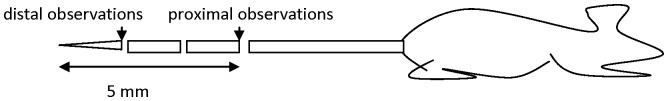
Locations of tail biopsy examination sites.A 5/6 mice at 0, 3, and 7 days postpartum (PPD). The tissue was cut into 3 pieces and prepared for toluidine blue staining, transmission electron microscopy (TEM), and calcitonin gene-related peptide (CGRP) immunostaining. The arrows indicate the areas examined by TEM and bright field microscopy.